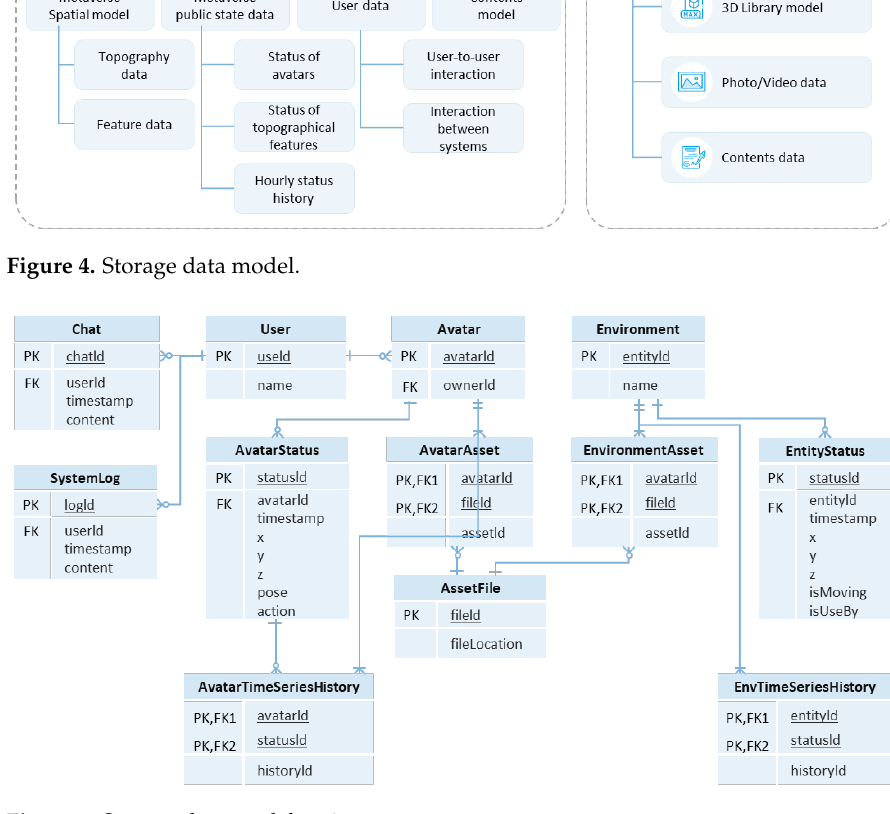
Figure 5. Storage data model entity. Table 3. Description of Each